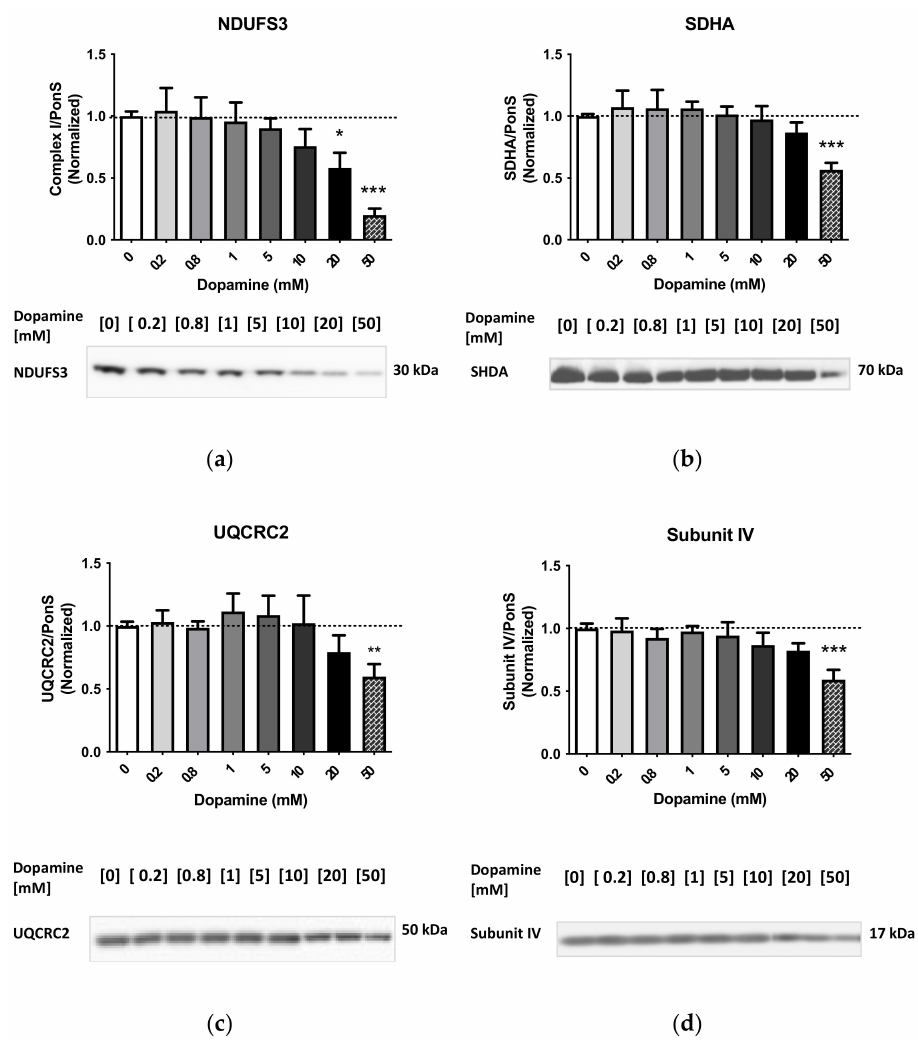
Figure 2. Effects of increasing doses of DA on the levels of subunit ( a ) NDUFS3 (complex I), ( b ) SDHA (complex II), ( c ) UQCRC2 (complex III), and ( d ) subunit IV (complex IV) in cytoplasm-suspended mitochondria. * p < 0.05, ** p < 0.01, *** p < 0.001, one-way ANOVA with Dunnett’s post hoc